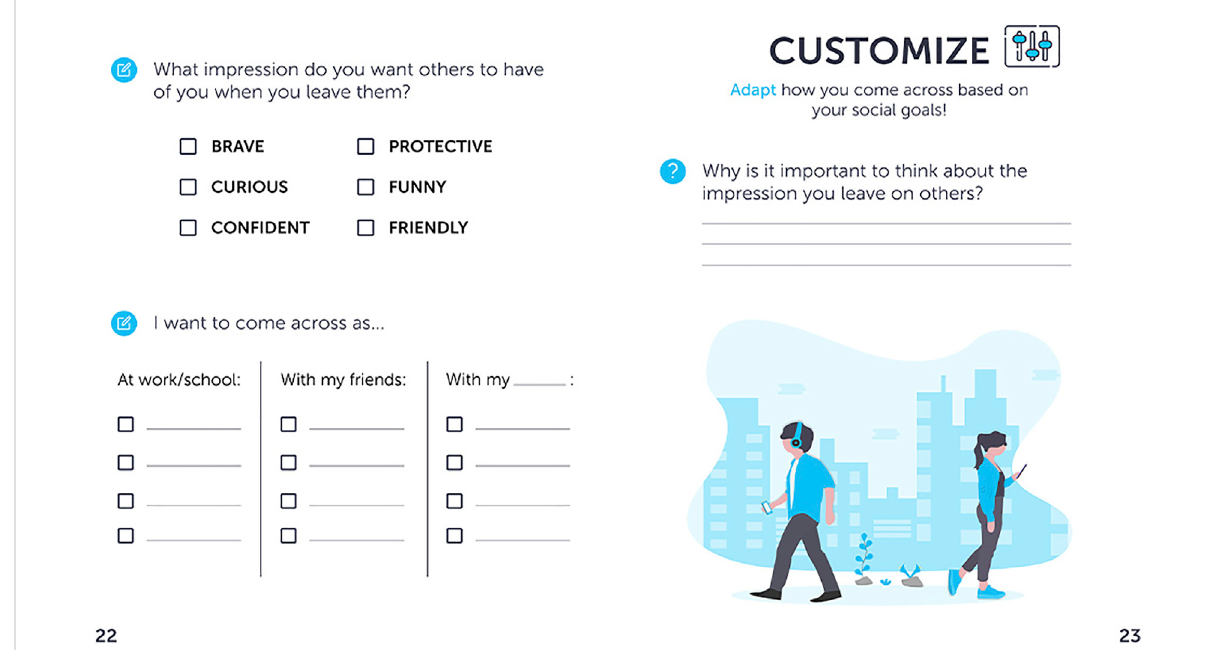
FIGURE 10 Strategy workbook page. Future Charisma ™ Virtual Social Coaching will offer both interactive digital training modules and a corresponding workbook for strategy training.